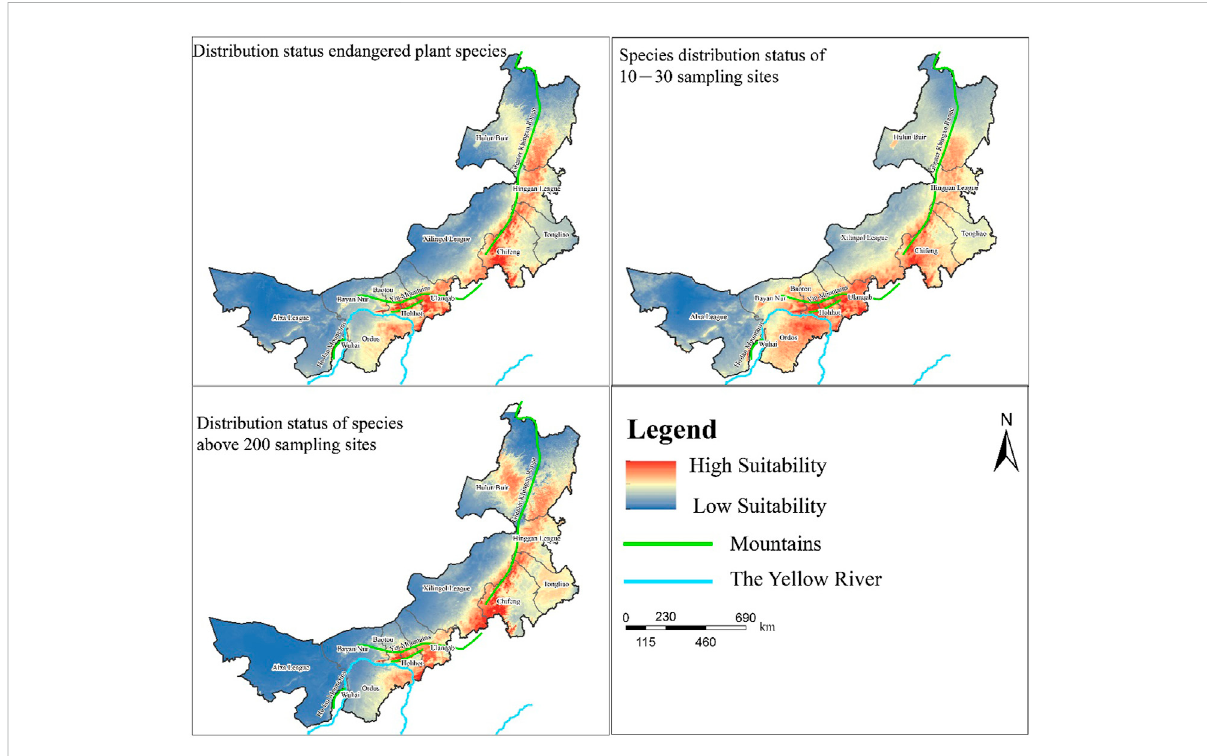
FIGURE 5 Habitat suitability distribution of medicinal plant diversity in Inner